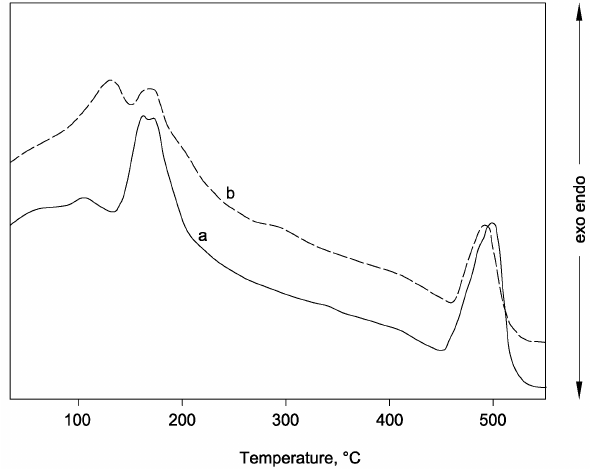
Figure 7. Thermal analysis results for the system C ( a ) 7 days; and ( b ) 28